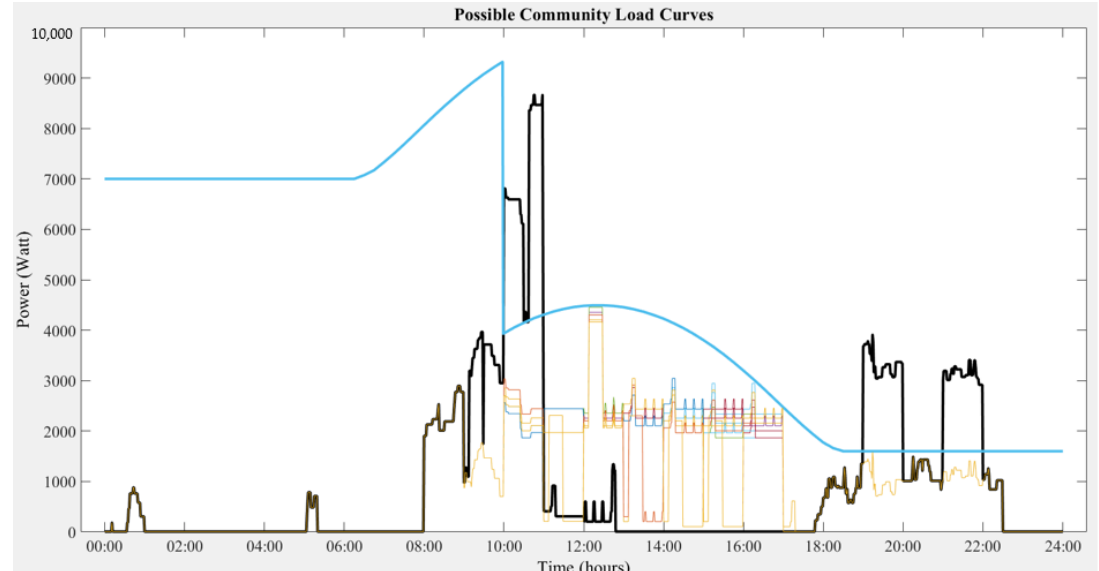
Figure 18. Possible solutions for the community’s demand profile regarding Scenario 3.